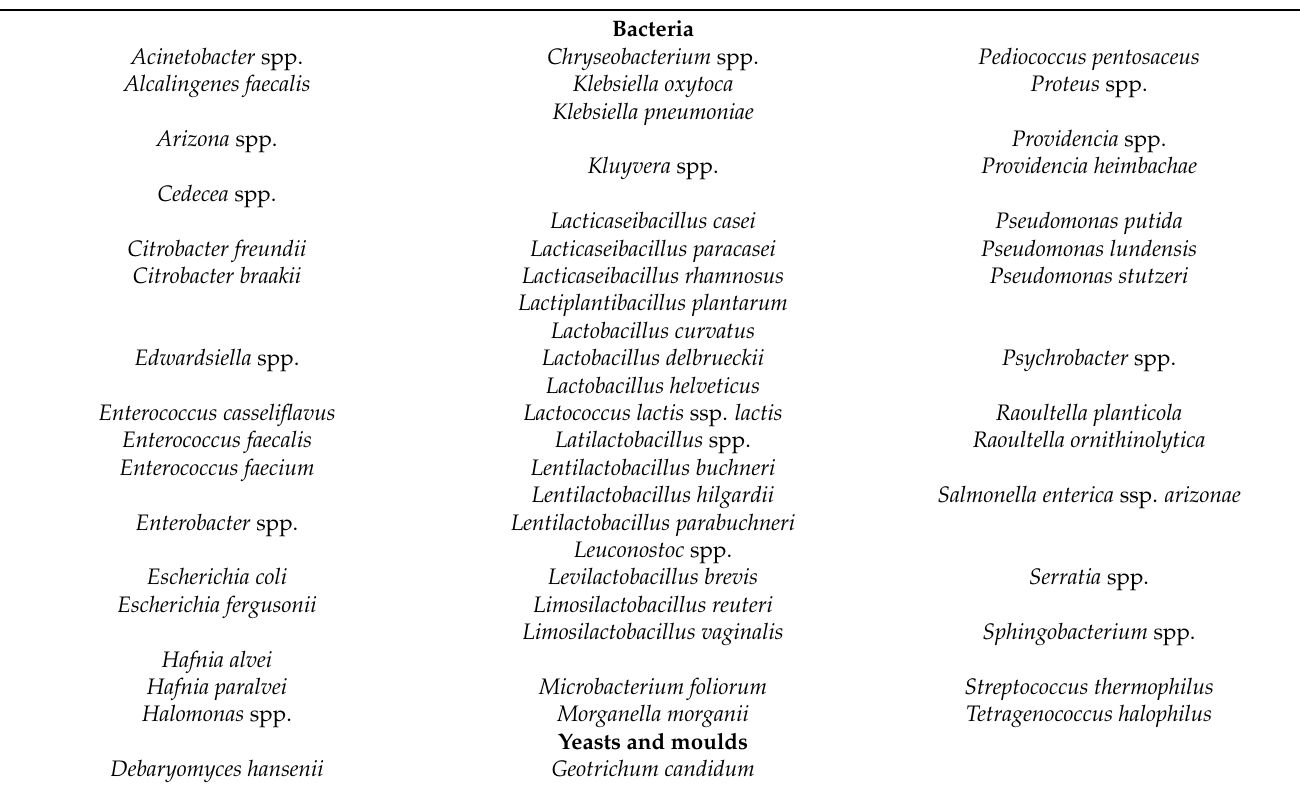
Table 4. Microbial genera or species which may have the capacity for histamine formation. Adapted according to